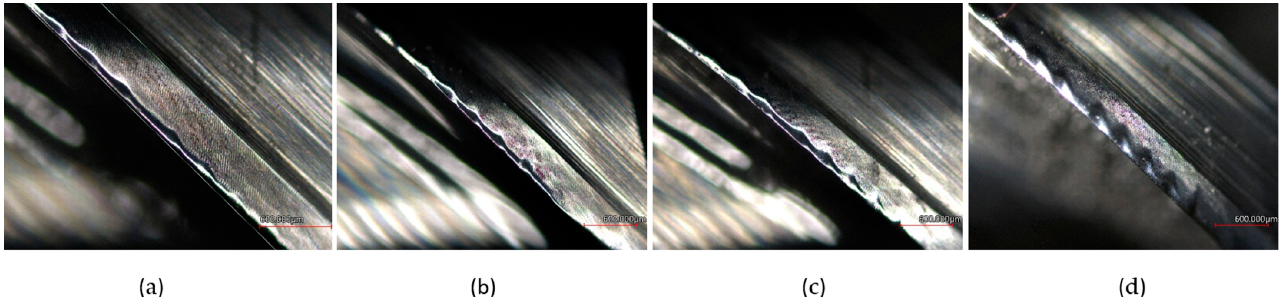
Figure 29. Tool wear of the A100 milling tool, laminate thickness 3 mm. ( a ) Tool tooth path 5 × 165 m; ( b ) tool tooth path 10 × 165 m; ( c ) tool tooth path 15 × 165 m; ( d ) tool tooth path 20 × 165 m.